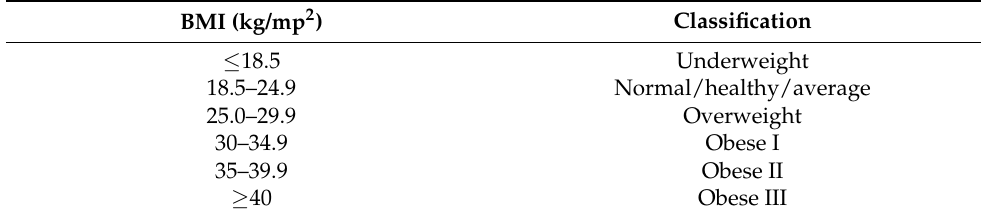
Table 1. Classification of weight status according to BMI